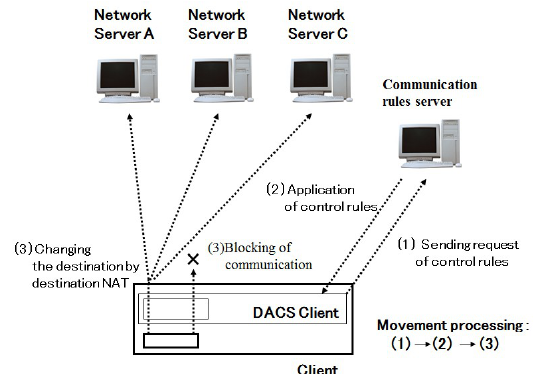
Figure 3. Principle in Second Scheme